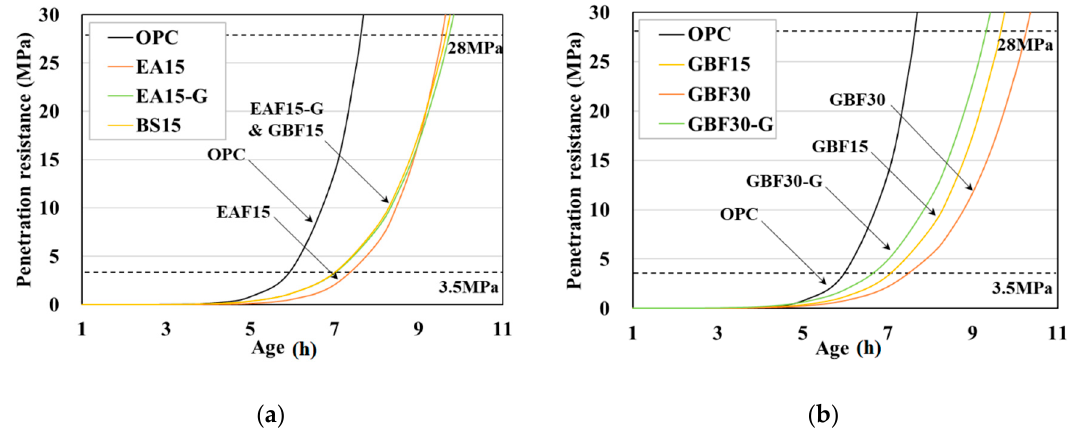
Figure 2. Setting times of different types of concrete. ( a ) Results of EAF series and ( b ) results of GBF series.